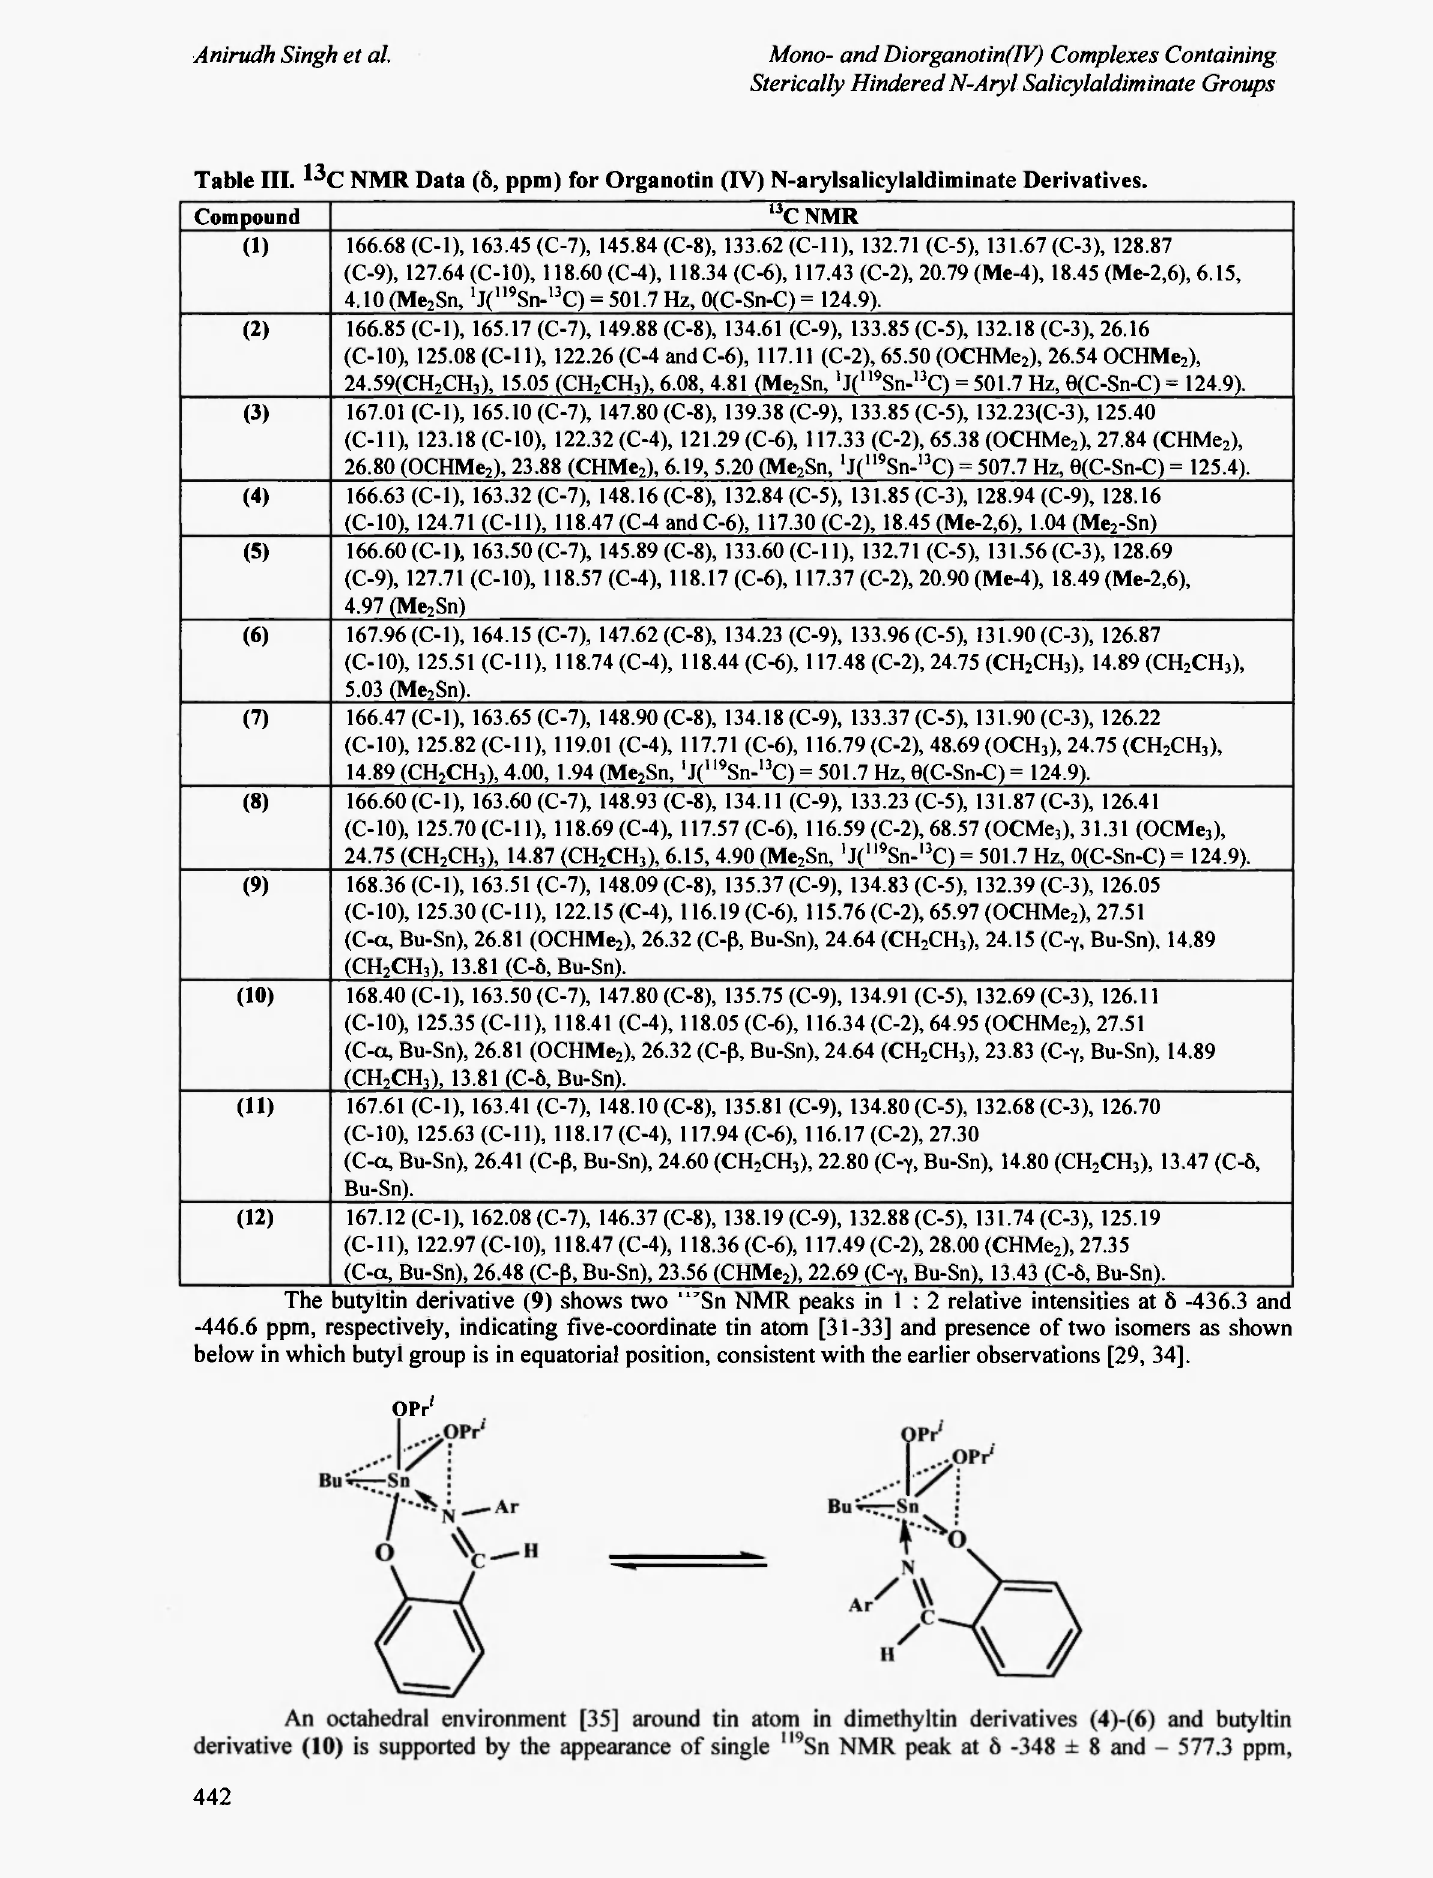
Table III. ^C NMR Data (δ, ppm) for Organotin (TV) N-arylsalicylaldiminate Derivatives. Compound